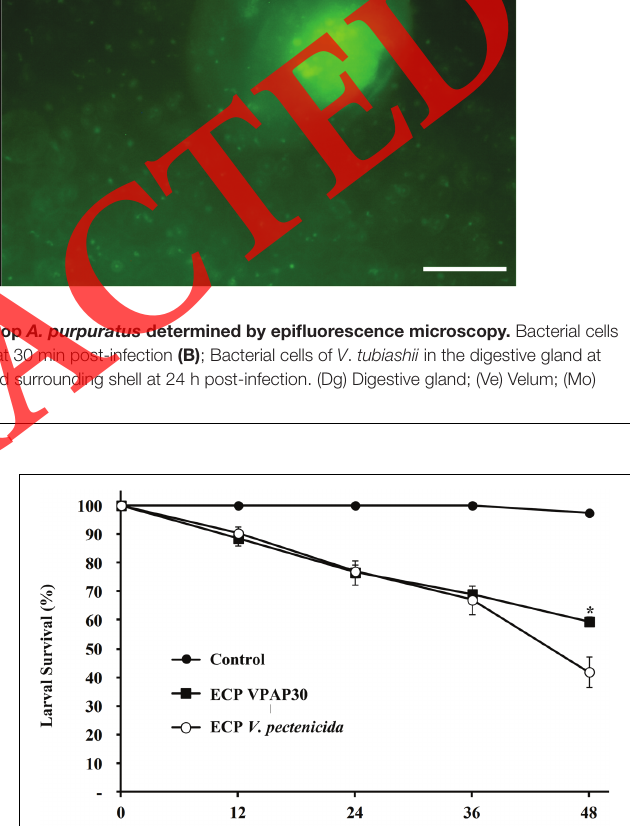
pathogenic to mollusc larvae. For example, Yue et al. (2010) estimated a LD 50 of ∼ 6 × 10 6 CFU mL − 1 for a Vibrio parahaemolyticus -related strain pathogenic to larvae of